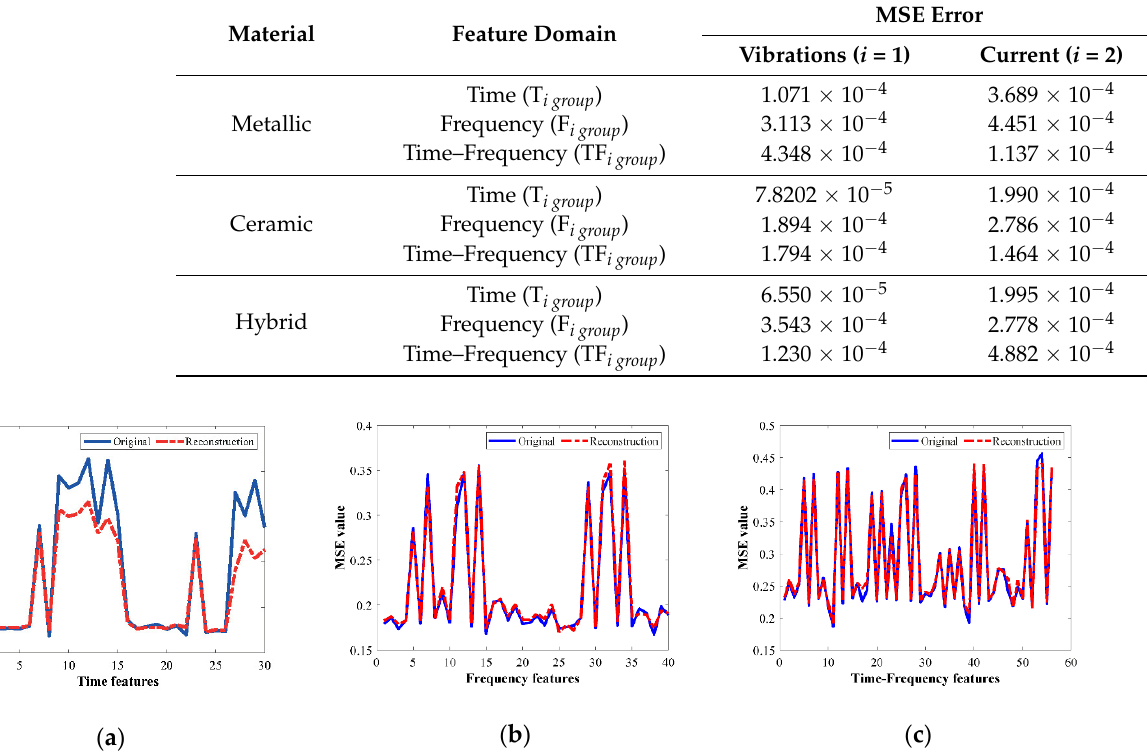
Figure 8. Qualitative representation of the original and reconstructed set of features for healthy metallic bearing at 5 Hz. ( a ) TD feature vibrations, ( b ) FD feature vibrations, ( c ) TFD feature vibrations.